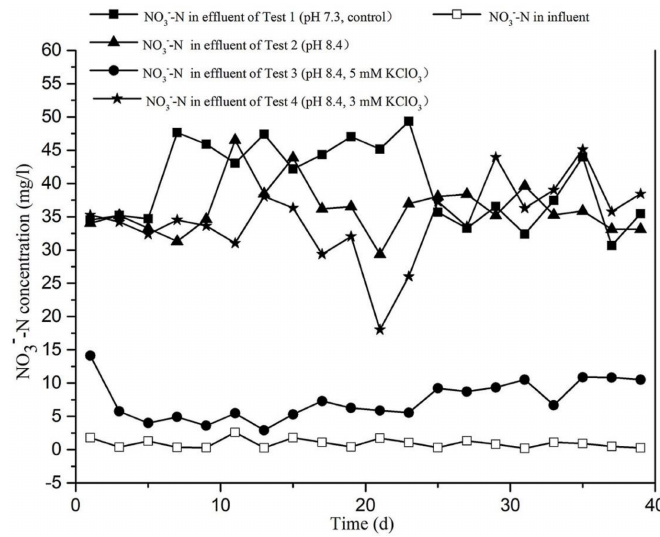
Figure 6. The nitrate-nitrogen concentration in influent and effluent in the four experimental tests of CRI